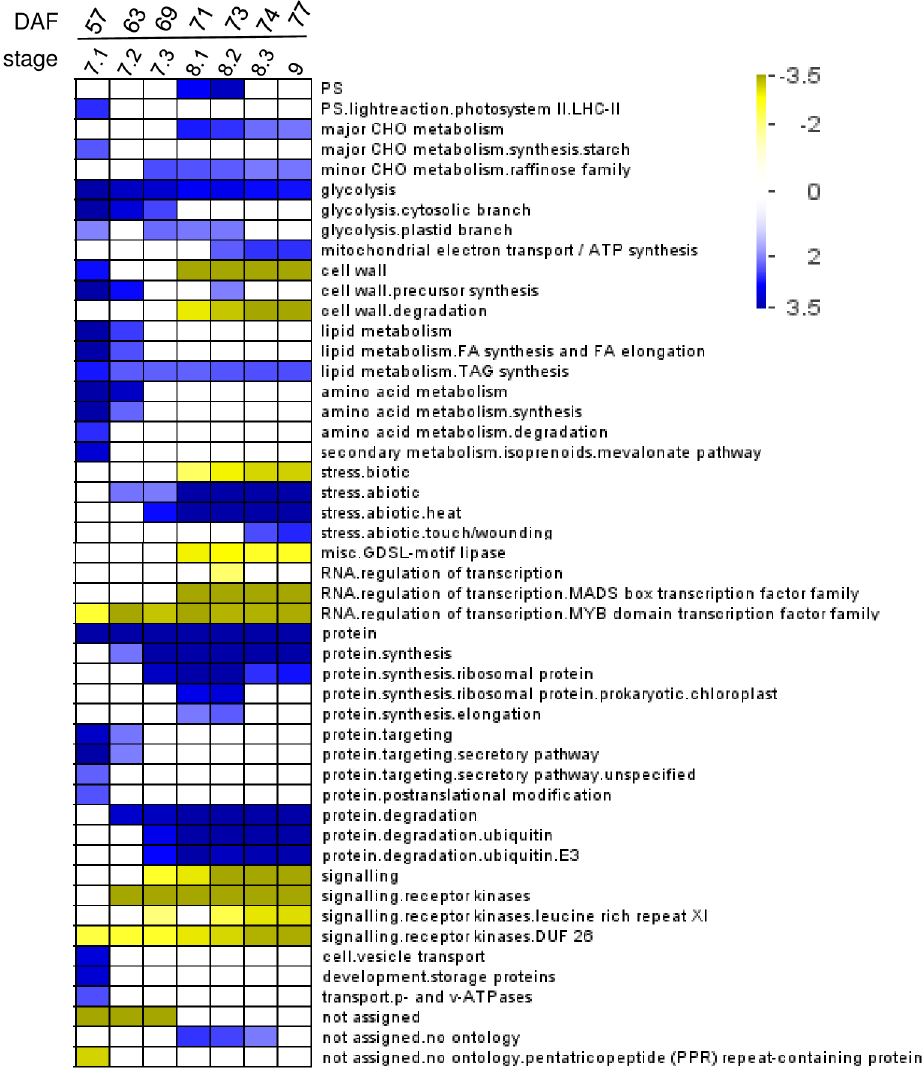
Fig 4. Over-representation analysis of functional classesduring seed maturation. Functional classes and subclasses statistically affected are indicatedaccordingto Mapman ontology. Data were subjectedto a Bin-wiseWilcoxon test and resultingp-valueswere adjustedaccordingto Bonferroni. The scale bar indicates the z-score calculatedfrom p-values ( i . e . p-valueof 0.05 representsa z-score of 1.96 after adjustment). Over- represented and under-represented classes are indicatedrespectivelyin blue and